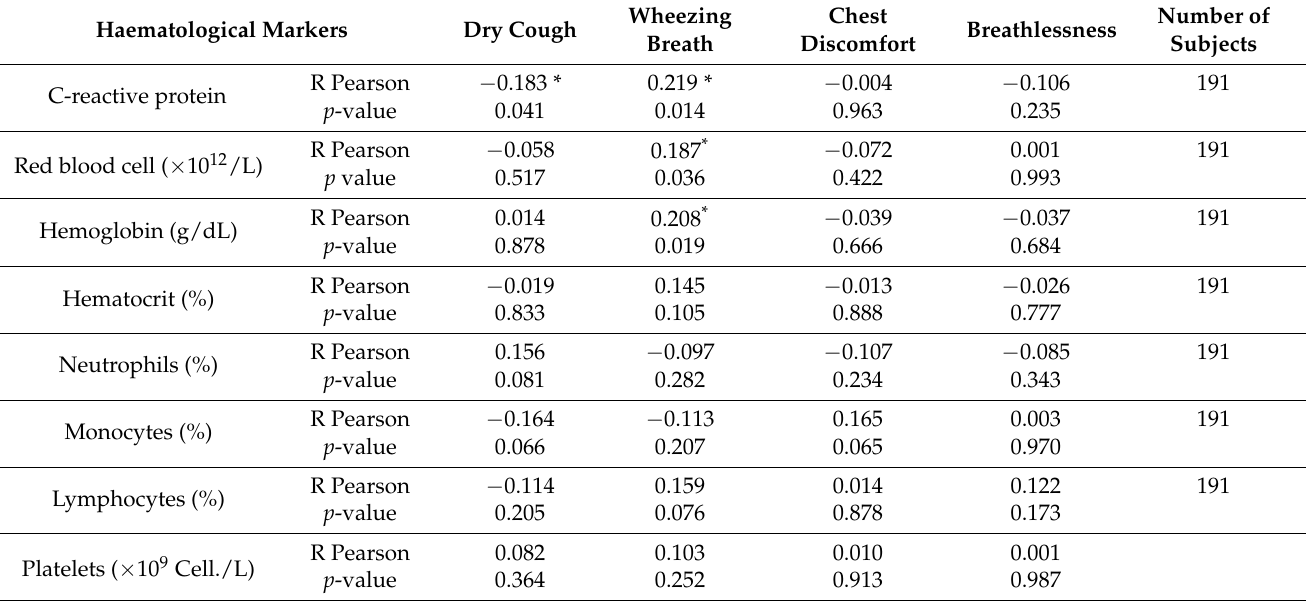
Table 9. Correlation between symptoms of lower airways and changes of haematological markers.